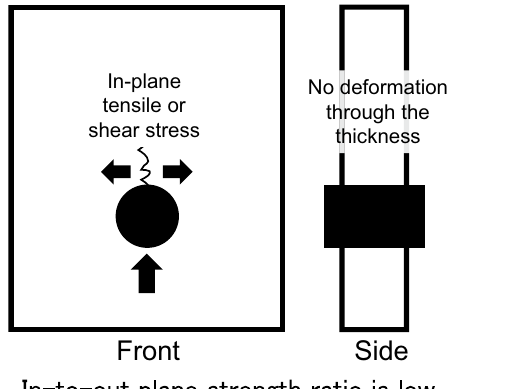
Fig. 8 Two fracture processes of the ESF